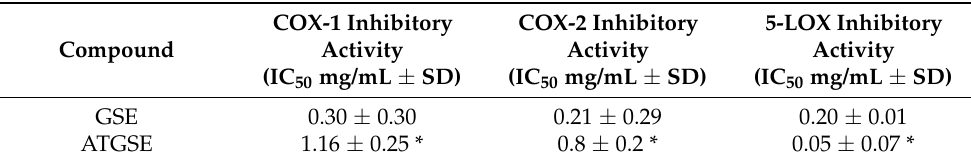
ATGSE Values are the mean ± standard deviation (SD) of three replications. Statistical significance is calculated by Student’s t -test analysis: * p < 0.05 GSE vs.